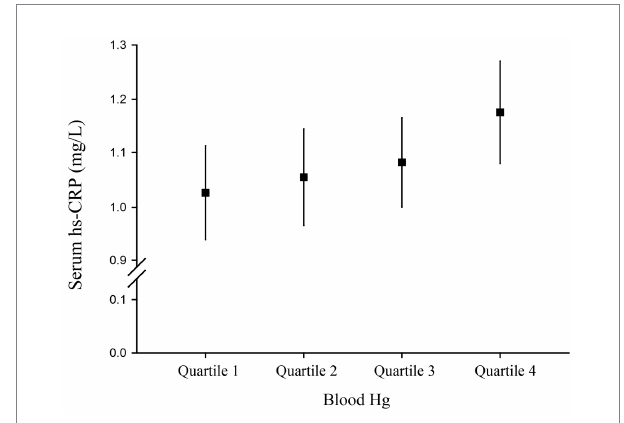
FIGURE 2 Serum high-sensitivity C-reactive protein (hs-CRP) level (95% confidence interval) by quartile of blood Hg.